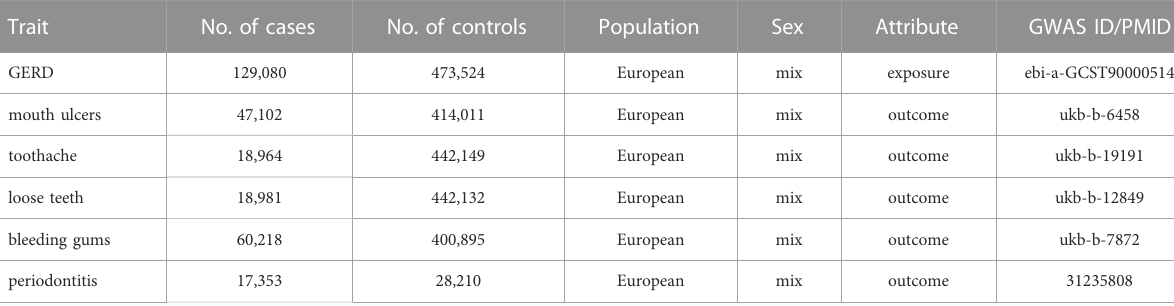
TABLE 1 Details of the GWAS included in the Mendelian randomization. Trait No. of cases